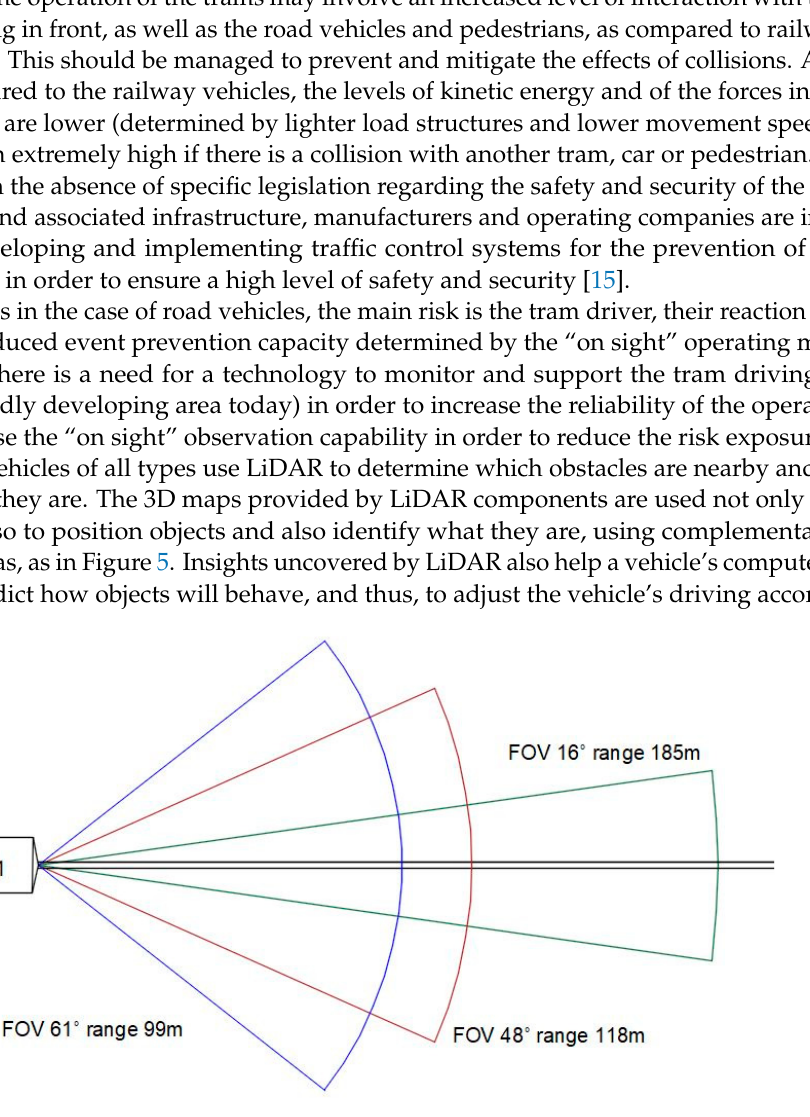
Figure 4. Configuration of LiDAR system used for tramcar safety.